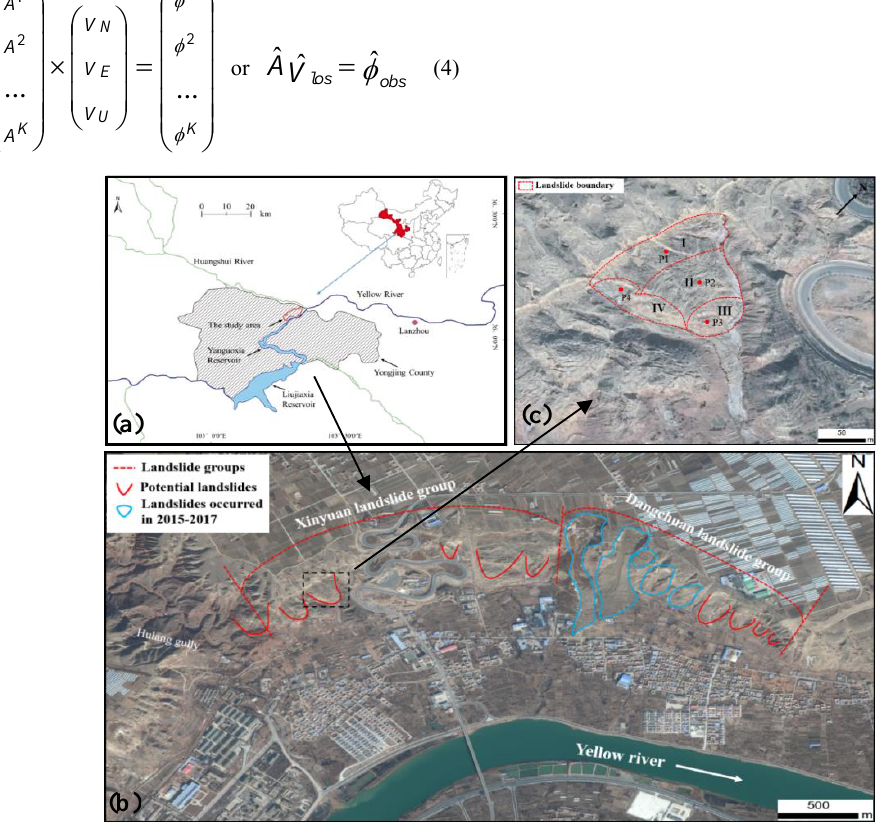
Figure 1. (a) Location of study region; (b) a wide view of the landslides in study area; (c) zoom in Xinyuan No.2 landslide, where points P1-P4 will be analyzed in Figure